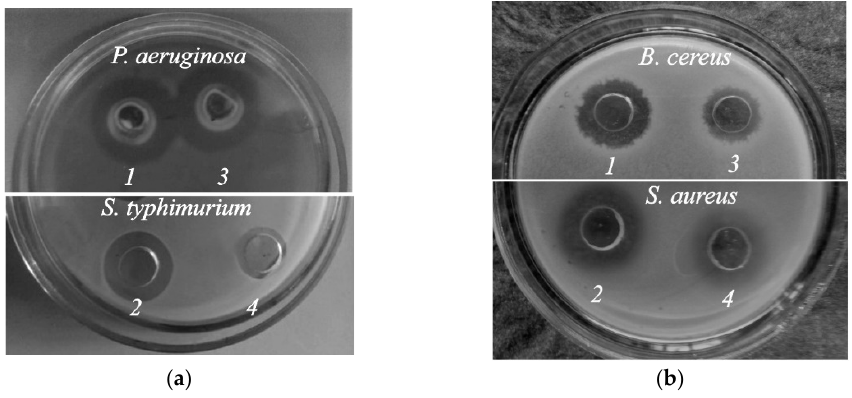
Figure 6. Growth inhibition zones of the test culture P. aeruginosa ATCC 9027, S. Typhimurium and B. cereus NCTC 8035 ( a ), B. cereus and S. aureus ( b ) by the CS · HCl:Pl F-127 = 30:70 (vol./vol.) hydrogels without ( 1 , 2 ) and with the addition of 3 wt.% D-AscA ( 3 , 4 ); C CS · HCl = 3 wt.%, C Pl F-127 = 25